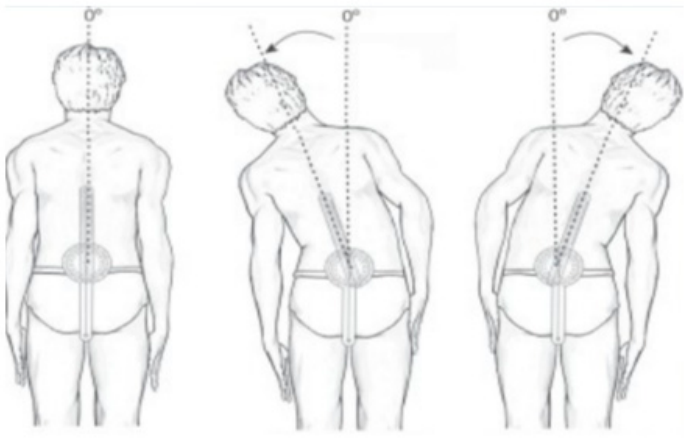
Figure 3. Lateral flexion ROM assessment.